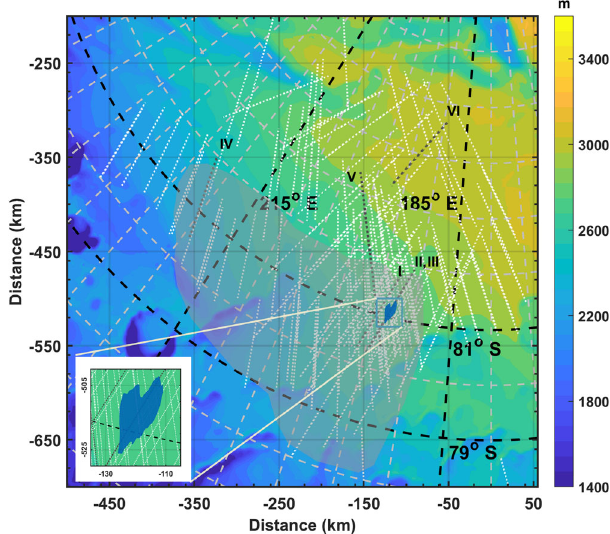
Fig. 1 | Mars Orbiter Laser Altimeter (MOLA) topographic map of the investi- gated area at Ultimi Scopuli. Dotted lines are MARSIS observations. The blue regionindicates the geographiclocation of the main bright area.The observations inthelight-grayshadowedareahavenotbeenusedfordatainversion,astheycross highandlowbasalre fl ectivityareasandcannotbeassignedneithertobrightnorto non-bright datasets. Black dotted lines refer to observations plotted in Fig. 2: 2654(V), 10737(II), 12685(III), 12780(VI), 14967(I), 19392(IV). Two tracks (II and